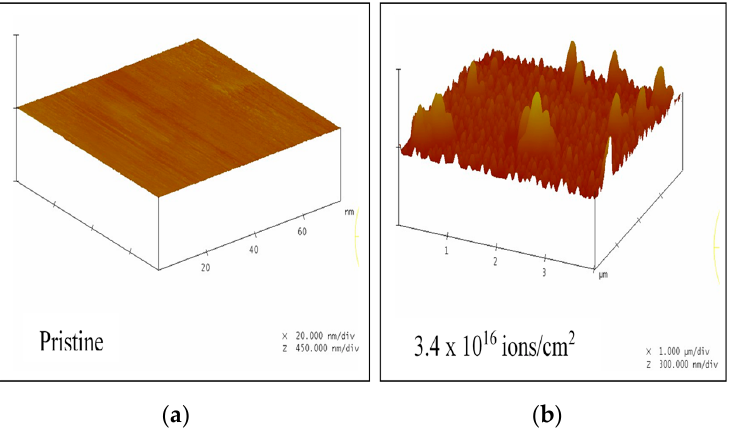
Figure 3. Surface roughness for ( a ) pristine and ( b ) Ag irradiated a-C thin film.